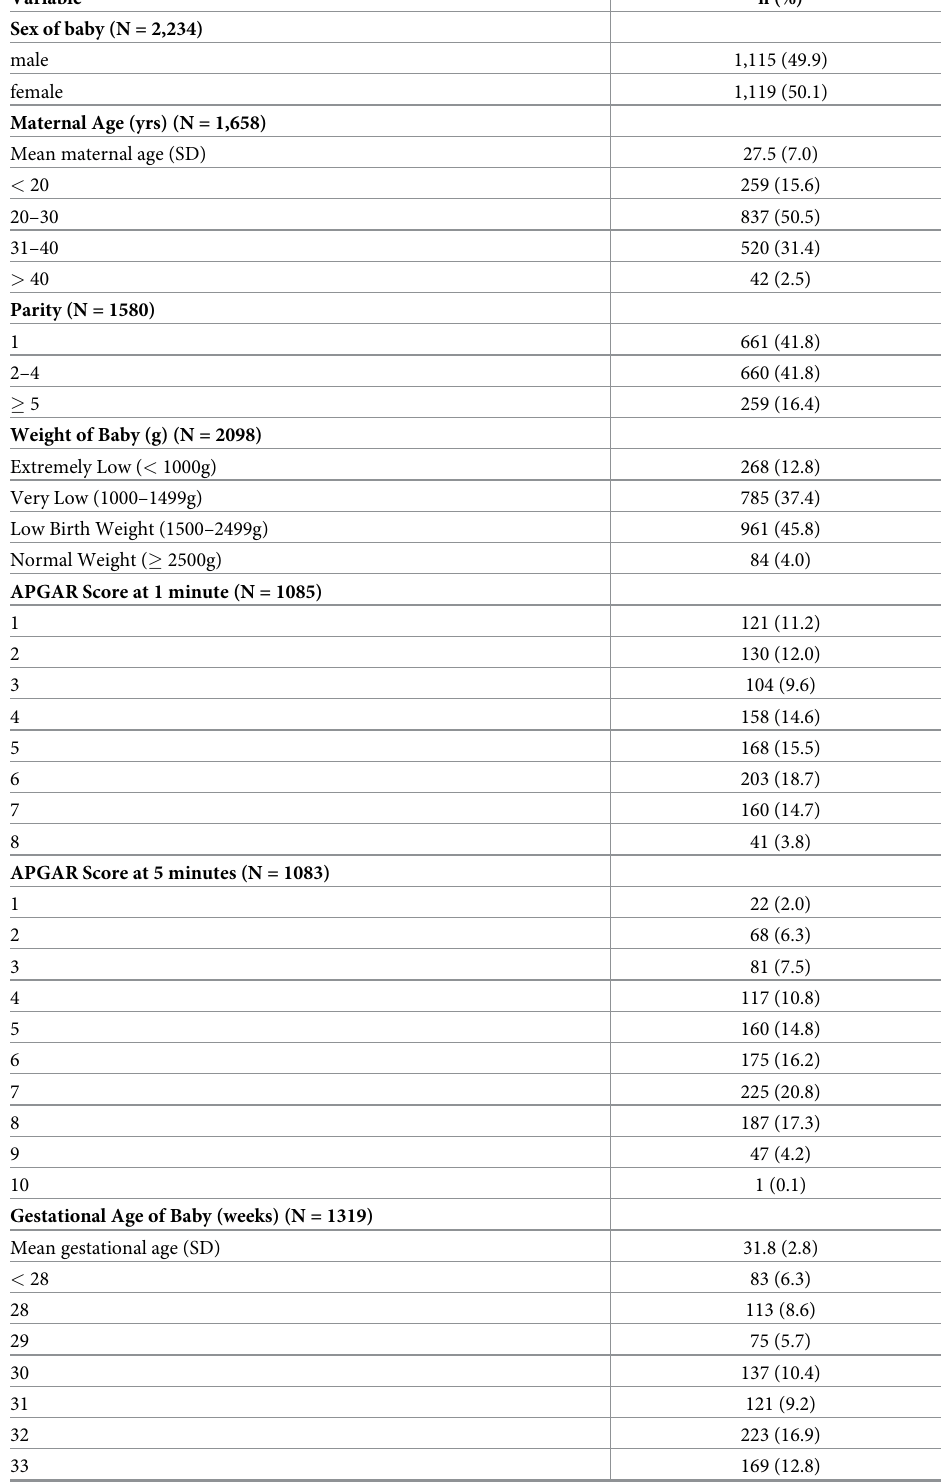
Table 1. Demographic and clinical characteristics of study